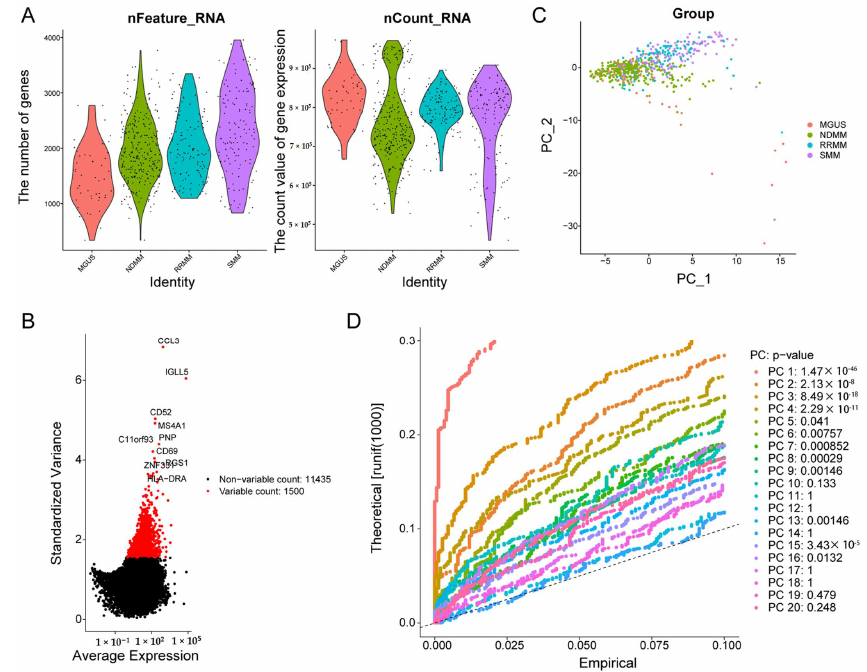
Figure 1. Quality assurance for single cell isolation and sequencing. ( A ). The gene descriptions and total gene numbers for the profiles. ( B ). Diagrams of differentially expressed genes between cells. ( C ). Results of PCA for single-cell sequencing. ( D ). p value of each PCA component. PCA: principal component analysis; PC-1: principal component-1; PC-2: principal component-2; MGUS: monoclo- nal gammopathy of undetermined significance; NDMM: newly diagnosed multiple myeloma; RRMM: relapsed/refractory multiple myeloma; SMM: smoldering multiple myeloma . 1 × 10 −1